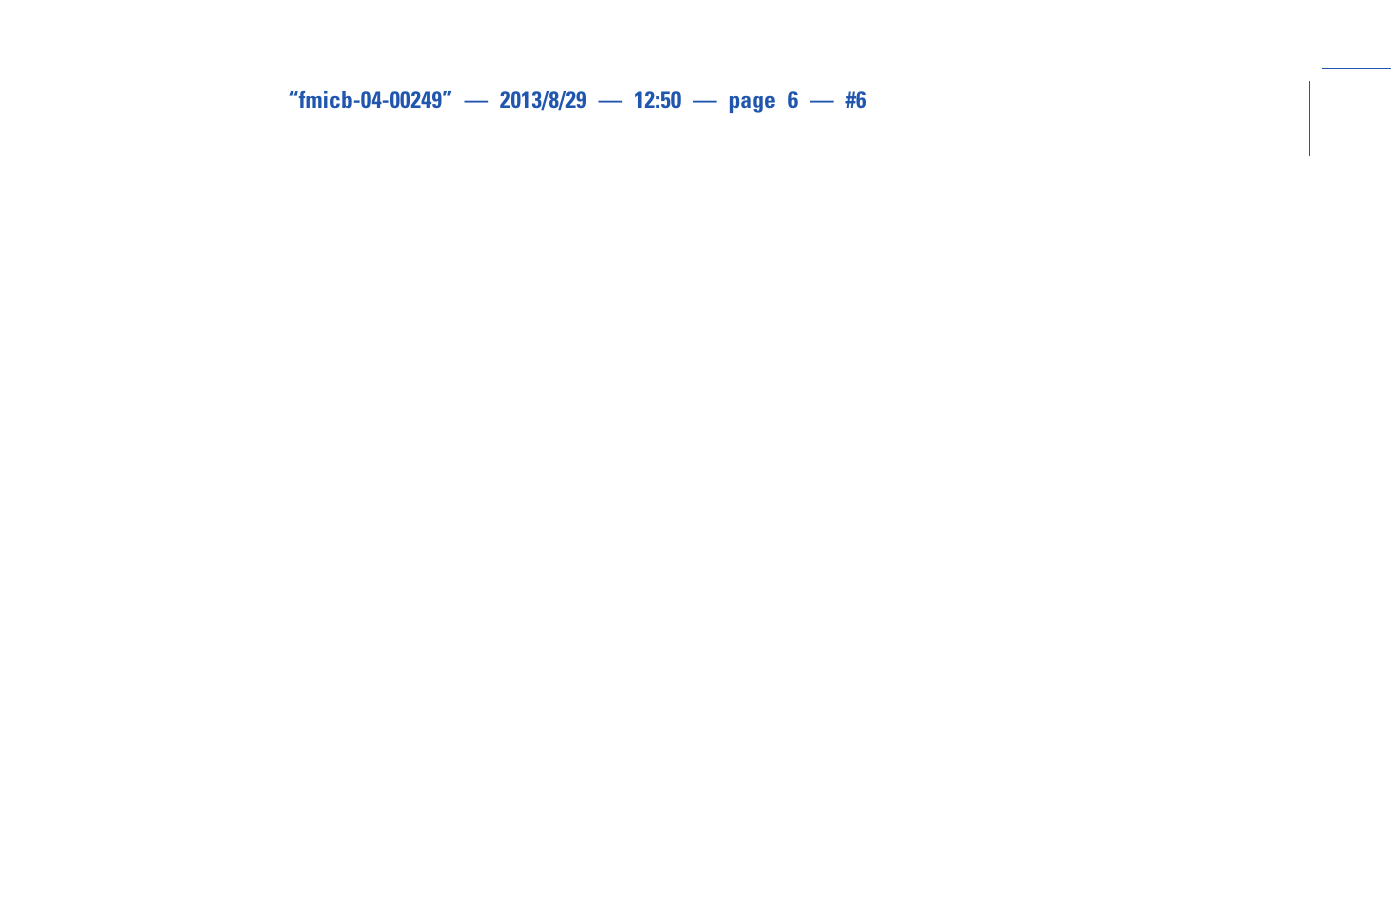
Table 2 | Strains, plasmids, and transposons used in this study. Strain, plasmid, or Genotype or markers; Source or reference transposon characteristics and uses